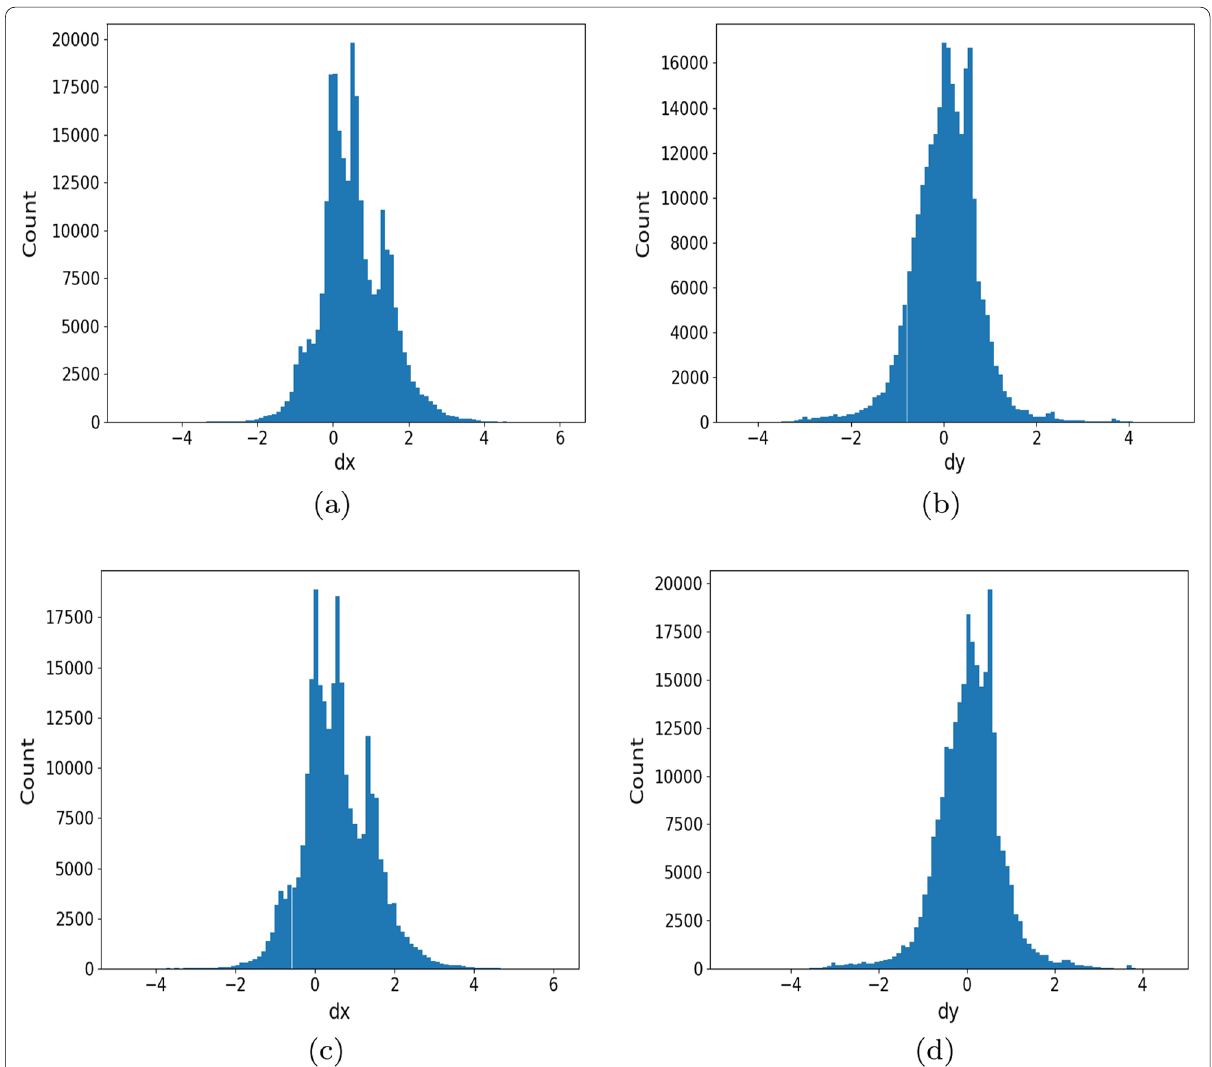
Fig. 7 Histograms of dust proposals: a , b d x and d y of the first training strategy and b d x and d y of the second training strategy; where d x refers to longitude and d y refers to latitude. The d x and d y are the deviation of the estimated position from the true position for each dust